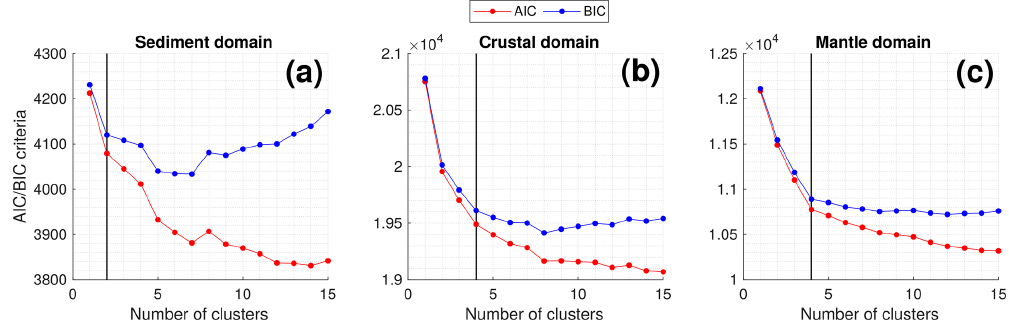
Figure 2. Theoretical information criteria AIC (Akaike information criteria) and BIC (Bayesian information criteria) to determine the number of clusters in each of the three domains: (a) sediment domain, (b) crustal domain, and (c) mantle domain. The vertical black line marks the chosen number of clusters, which is two in the sediment domain and four in the crustal and mantle domain, respectively.